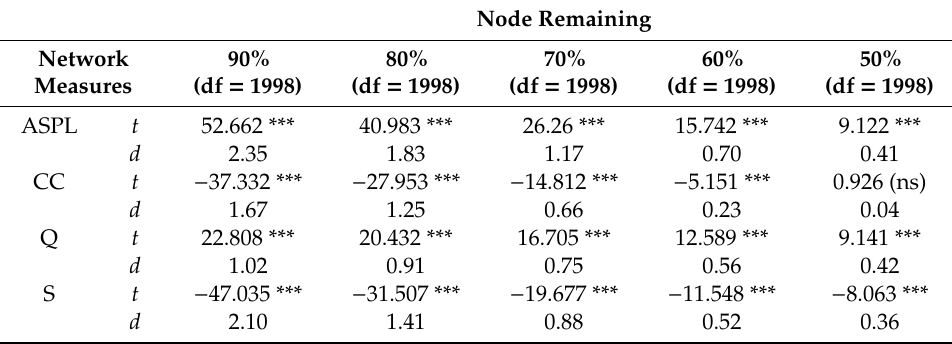
Table 4. Partial network bootstrapped results for the DT groups. Node Remaining